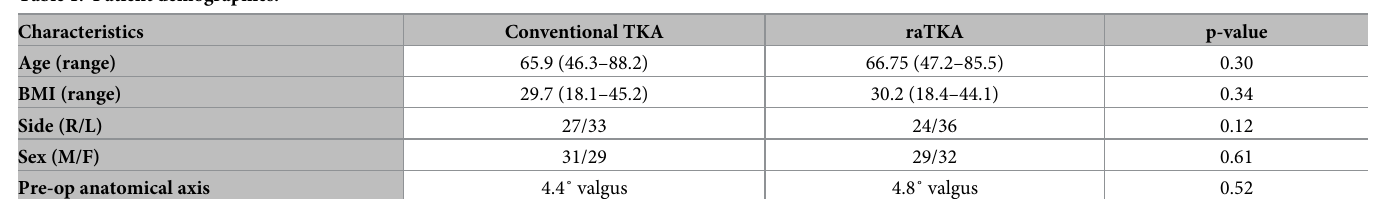
Table 1. Patient demographics.